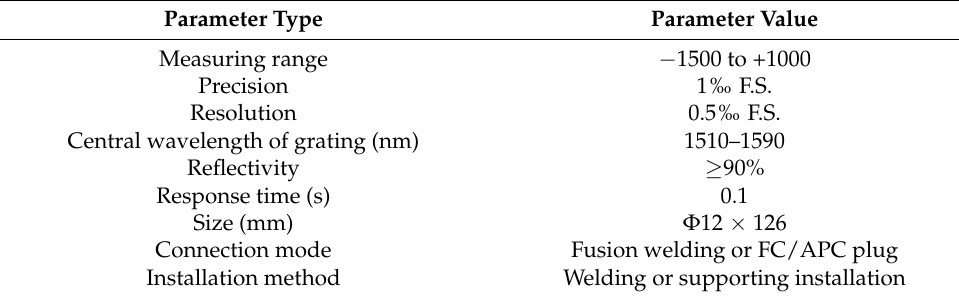
Figure 3. FBG strain sensor. Table 1. Main parameters of the FBG strain sensor.